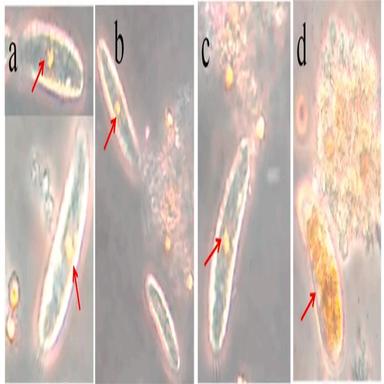
Ciliate ingestion of Symbiodiniaceae cells. Holosticha sp. ciliate cells with Symbiodiniaceae cells. Arrows denote Symbiodiniaceae cells.